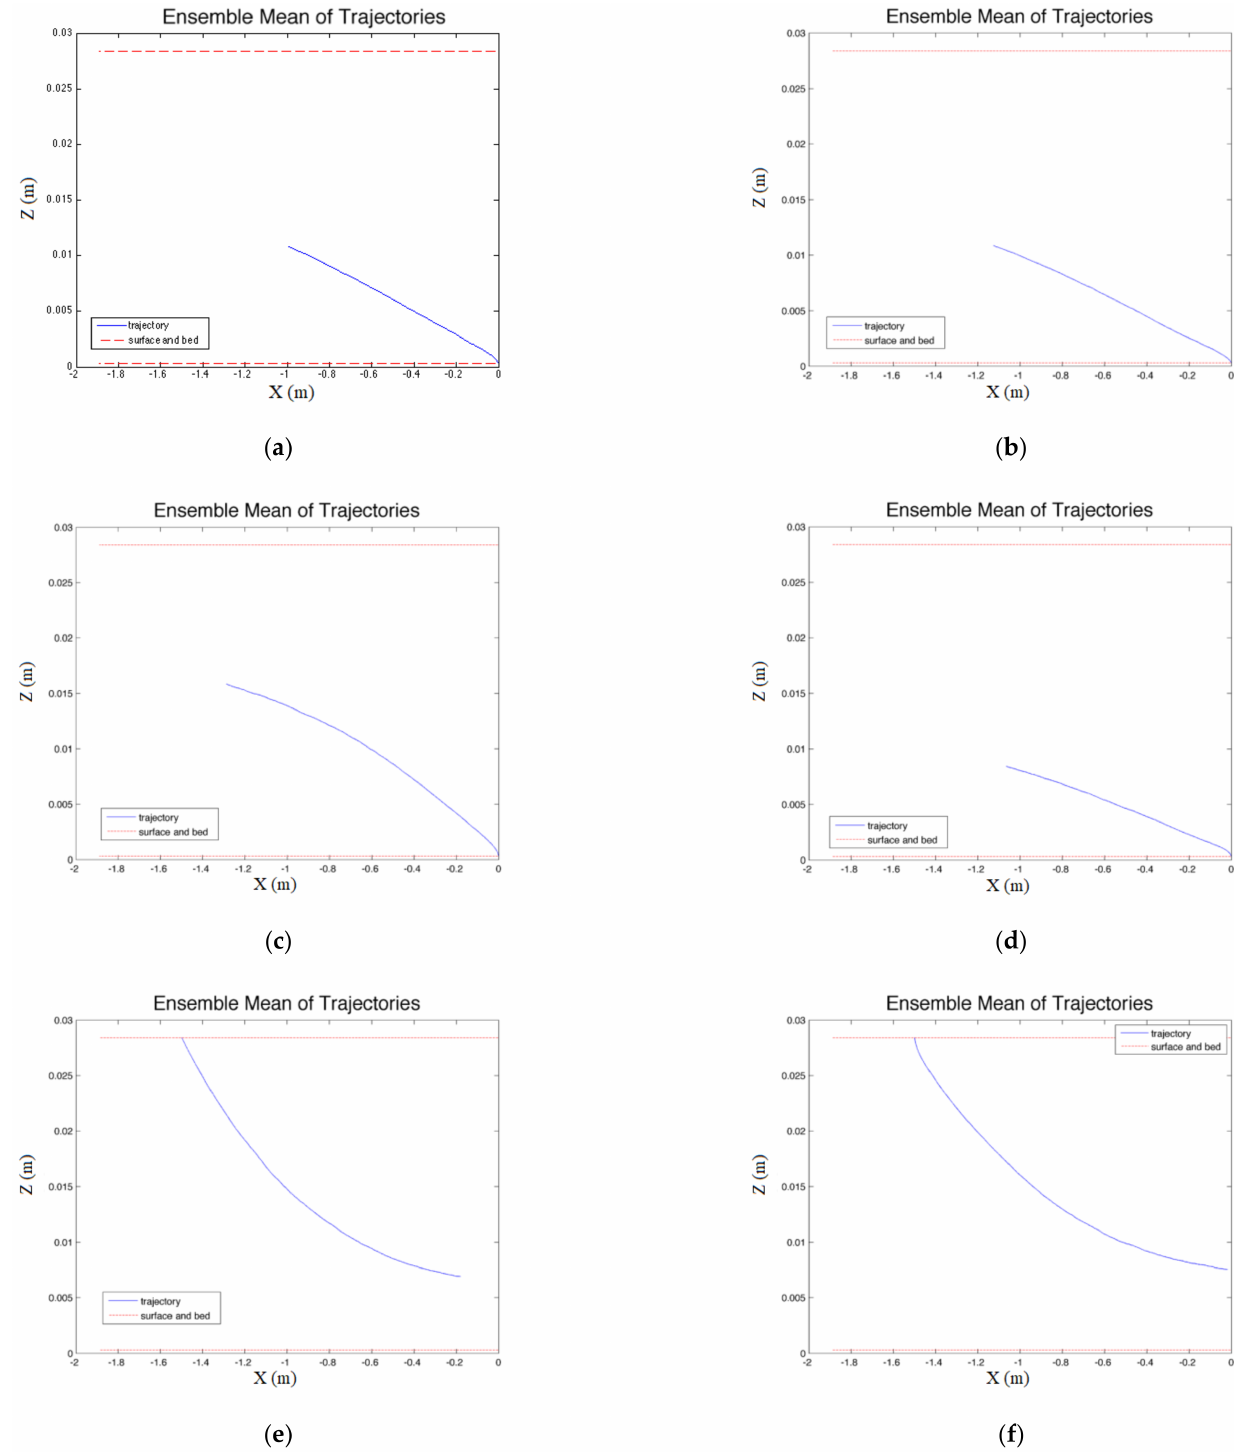
Figure 2. Mean Trajectory: ( a ) mean trajectory of backward tracking tests with the diffusivity of Rouse [37], using the explicit method; ( b ) mean trajectory of backward tracking tests with the diffusivity of Rouse [37], using the implicit method; ( c ) mean trajectory of backward tracking tests with the diffusivity of Absi et al. [38], using the explicit method; ( d ) mean trajectory of backward tracking tests with the diffusivity of Absi et al. [38], using the implicit method; ( e ) mean trajectory of forward tracking tests with the diffusivity of Rouse [37], using the explicit method; ( f ) mean trajectory of forward tracking tests with the diffusivity of Absi et al. [38], using the explicit